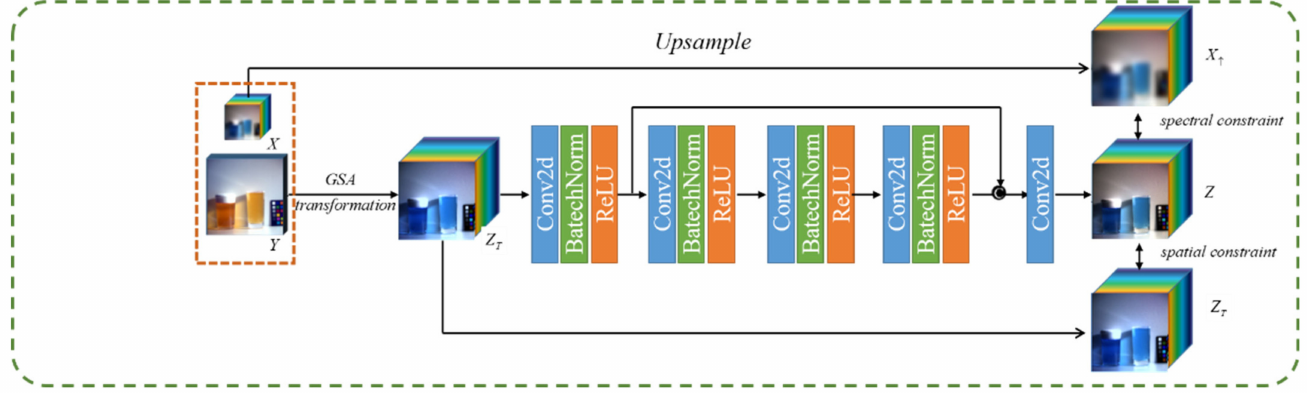
Figure 1. Framework of our